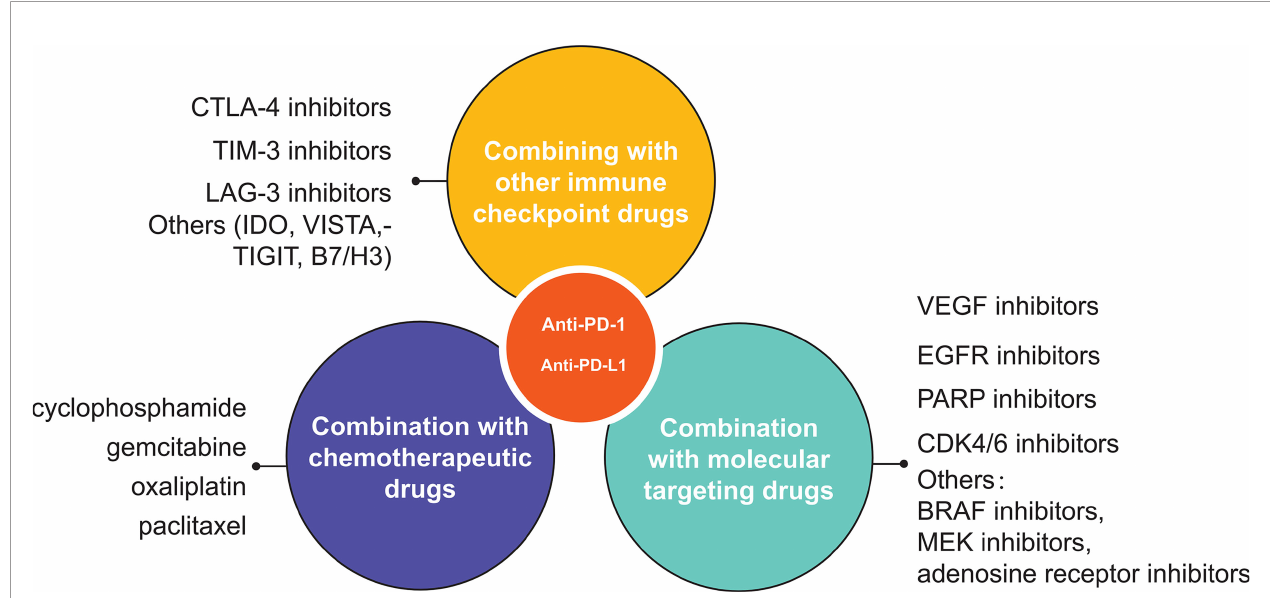
FIGURE 3 | A schematic overview of various uses of PD1/PD-L1 inhibitor in oncology. The three main types of combination are other immune checkpoint inhibitors, chemotherapy and molecular targeted